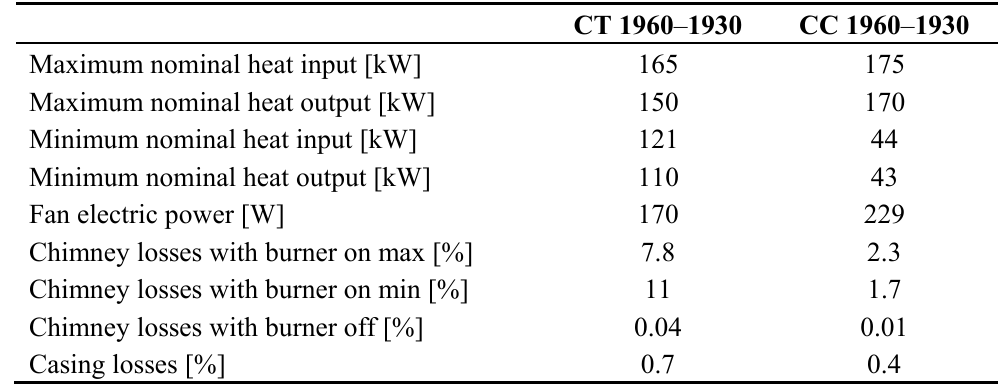
Table 4. Technical data of the considered boilers: centralized traditional installed in buildings dating back to 1960s and 1930s (CT 1960–1930) and centralized condensing installed in buildings dating back to 1960s and 1930s (CC 1960–1930).